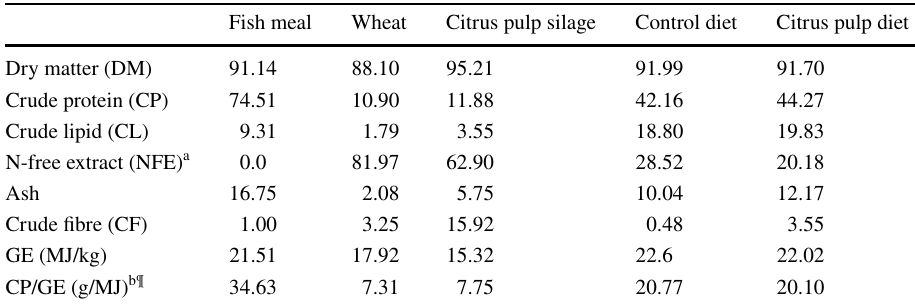
Table 2 The bromatological composition of the raw material and experimental diets, expressed in dry matter